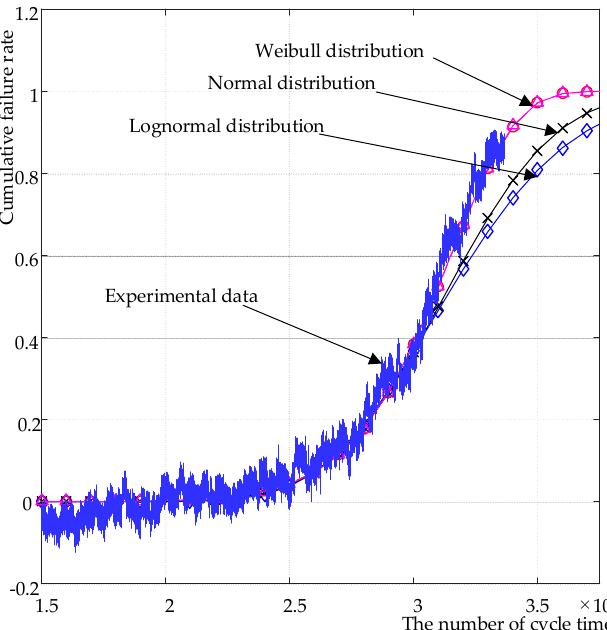
Figure 3. Comparison between data curves of single-direction 1500 A fatigue test and four distribution fitting results.